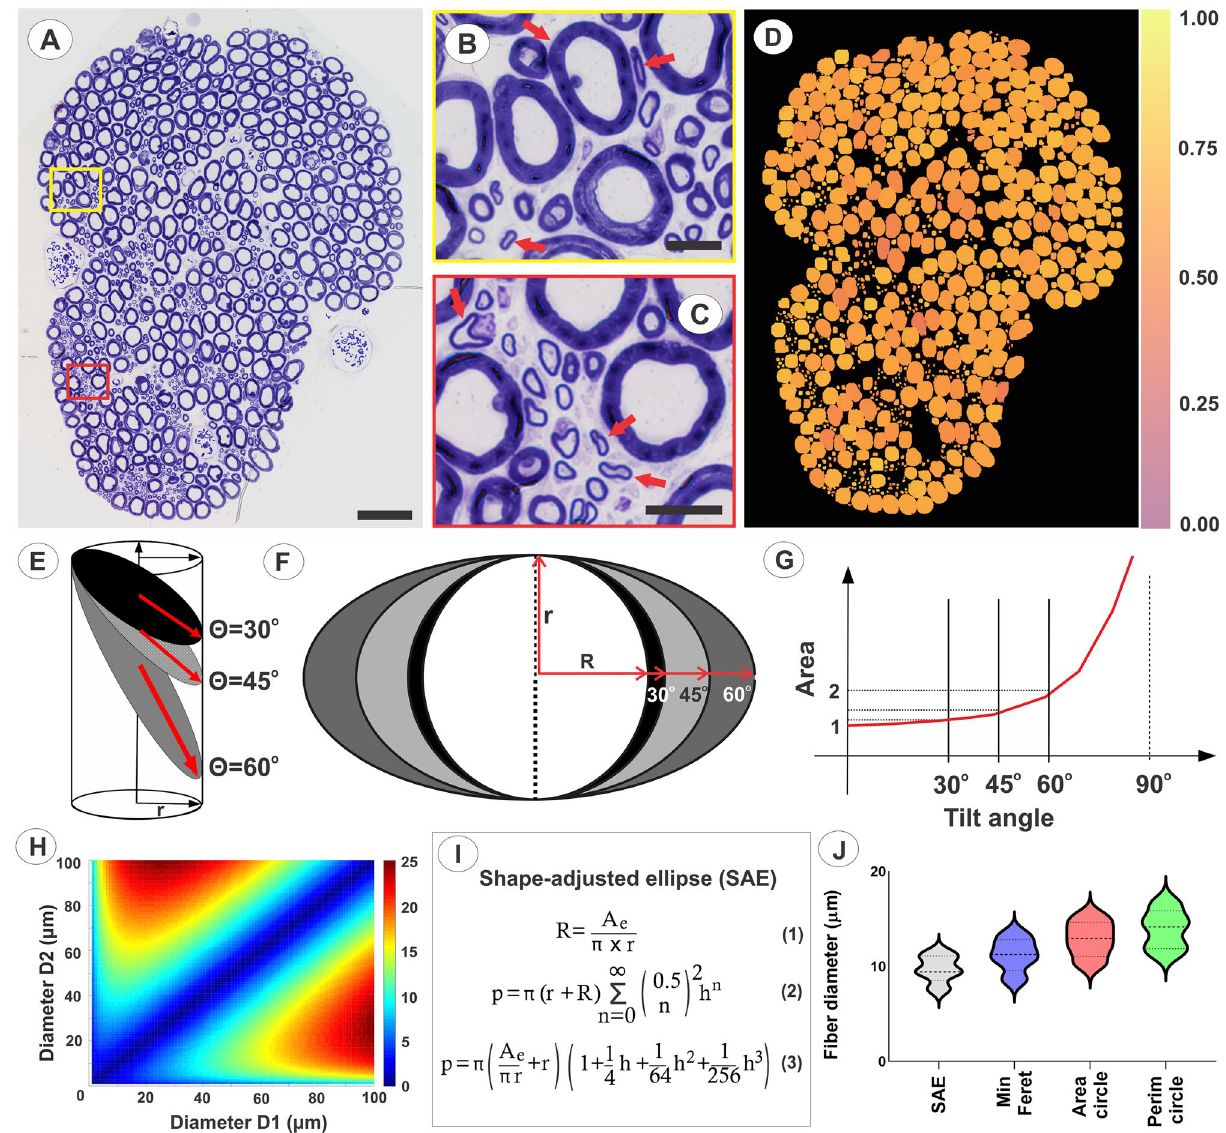
Figure 1. Shape adjusted ellipse (SAE) determination of nerve fiber size. ( A ) Transverse section of toluidine blue stained S1 ventral root in a female rhesus macaque. Note cross-sections of myelinated fibers of varied sizes. ( B,C ) Close-up view of boxed areas in ( A ), showing fiber shape heterogeneity, including presence of several elongated fiber presentations. Arrows indicate examples of non-circular shapes. ( D ) Heat map for S1 ventral root in ( A ) showing calculated roundness of myelinated fibers as a representative indicator for shape. Note marked heterogeneity of roundness for fibers across all sizes. A calculated roundness of 1 indicates a circular shape. ( E ) Sectioning of a cylinder with a circular base sectioned at different angles results in ellipse-shaped presentations of cut surfaces. ( F ) A cylinder in ( E ) sectioned at increasing tilt angles shows increased elongation and length of the long diameter of the corresponding ellipse-shaped cut surface. Note that the short diameter of the ellipse remains unchanged at all tilt angles. ( G ) Graph depicting error with overestimation of cylinder diameter, when the formula for a circle is used to calculate the diameter for the cross sectional surface of a cylinder cut at different tilt angles. Note the non-linear relationship between ellipse tilt angle and progressive diameter overestimation, especially for tilt angles over 30 degrees. ( H ) Heat map demonstration of the non-linear error introduced by an increasing difference between the two perpendicular diameters of an ellipse, Diameters 1 and 2, when the formula for a circle is used to calculate the diameter. ( I ) Summary of proposed SAE approach to calculate the minor diameter of an ellipse. The long-established formula for ellipse area (Eq. (1)) is combined with a more recently developed infinite series formula for determine ellipse perimeter 56 (Eq. (2)). The SAE approach is based on the notion that an elongated 2-dimensional surface with a known area and perimeter corresponds to a unique ellipse shape. The SAE equation is achieved by replacing R in Eq. (1) with A e /πr and expanding the first four terms of the infinite series (Eq. (3)). The equation is solved for r for a shape with known area and perimeter, and the minor diameter for the ellipse is next calculated as 2r. A e = area of ellipse; R = long radius; r = short radius; p = perimeter of ellipse; h = (R − r) 2 /(R + r) 2 . ( J ) Violin plots of fiber diameter distributions. The violin plots show distributions myelinated fiber distributions with median and quartiles for diameters obtained by the SAE approach as well as for minimum Feret diameters and circle-based diameters after determining fiber area or perimeter. Note significant overestimations of fiber diameters when traditional methods were